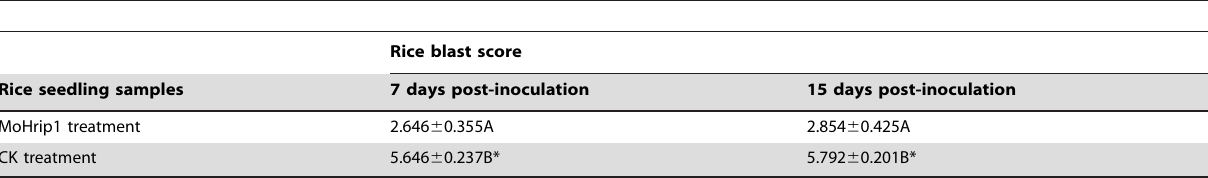
Table 1. Disease severity of rice blast in leaves of elicitor-treated and control-treated rice plants.